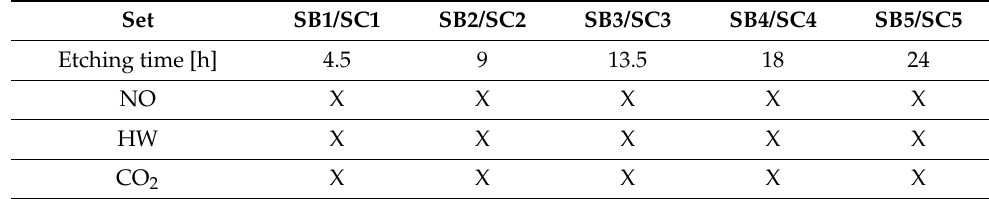
Table 2. Conditions for Experiment 2 ( 241 Am irradiation and radon